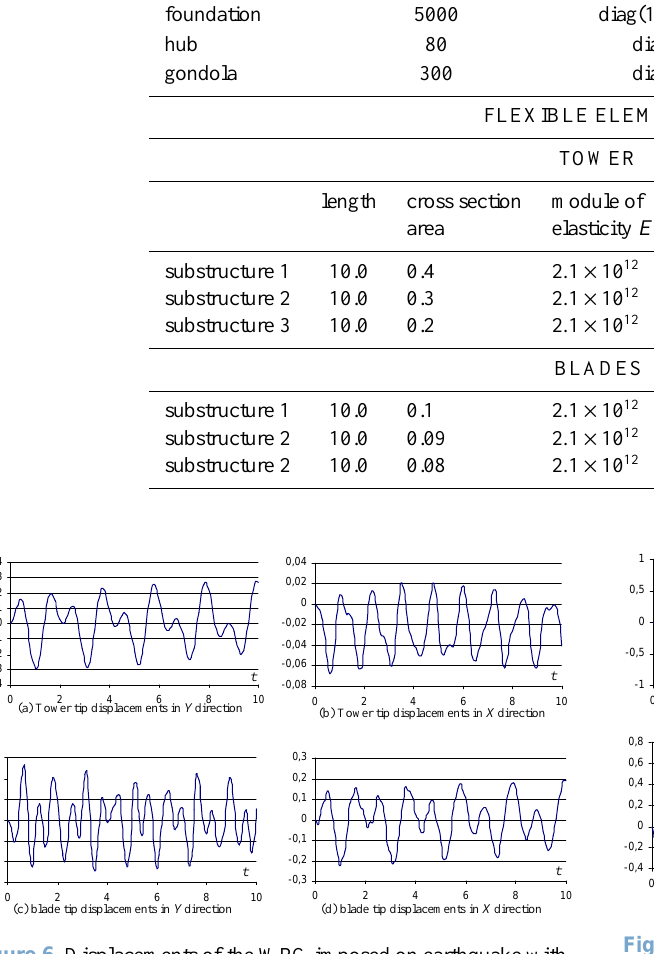
Figure 6. Displacements of the WPG imposed on earthquake with- out rotation of the turbine.